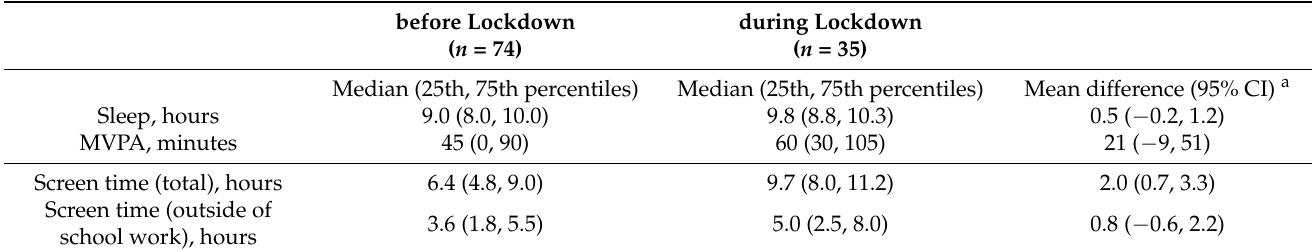
Table 2. 24-h time-use factors by lockdown ( n =